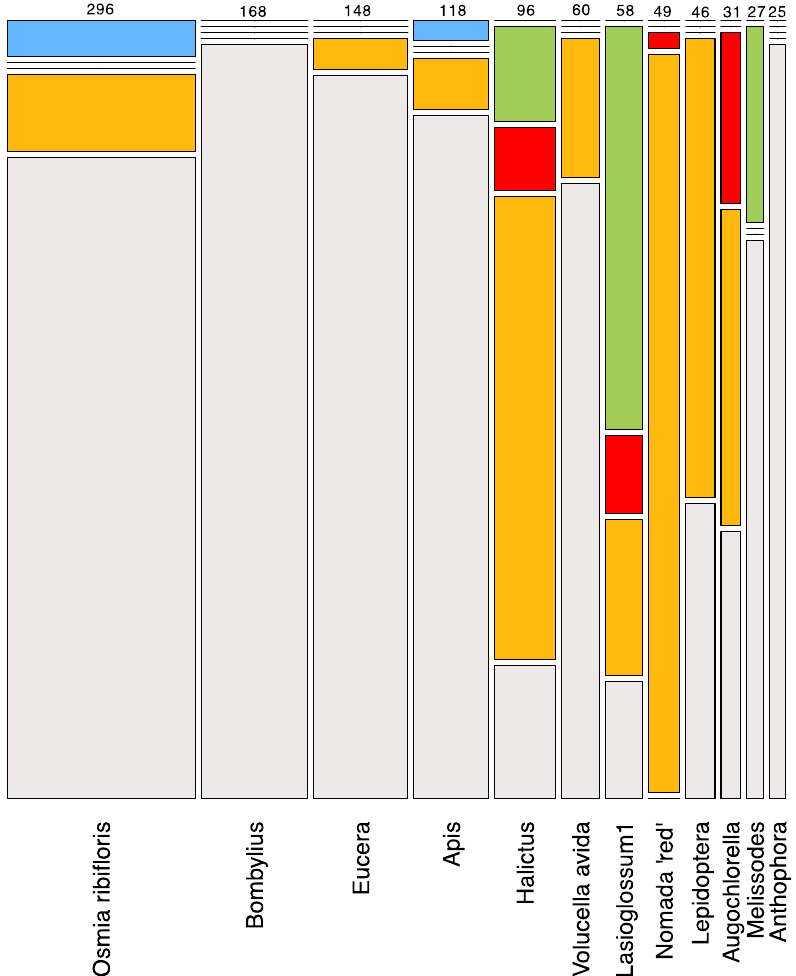
behaviours. Details on individual